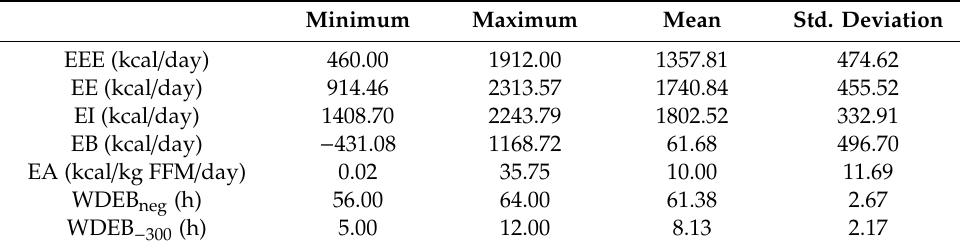
Table 2. Descriptive statistics of the energy-related parameters.